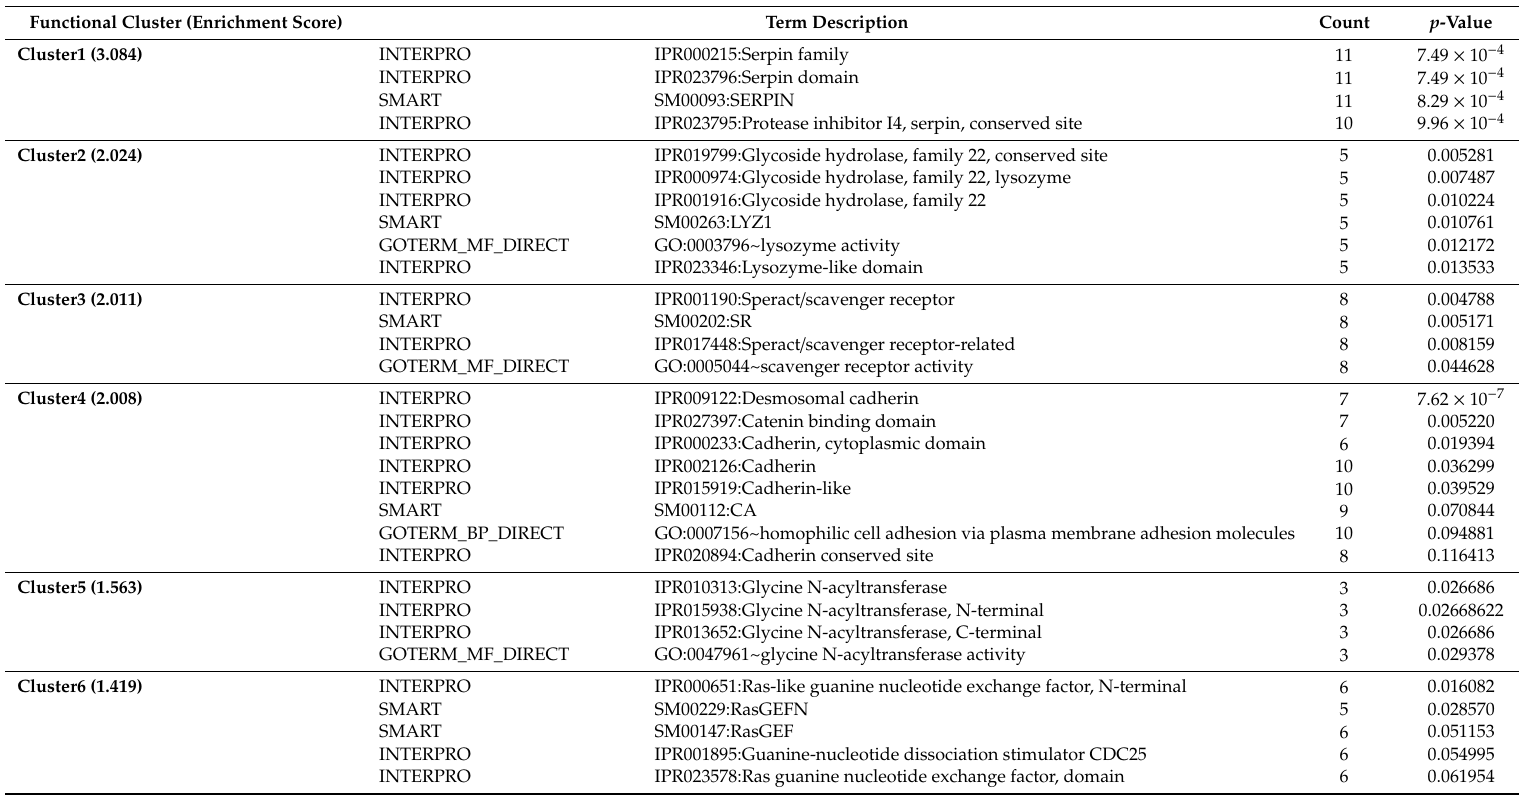
Table 1. Significantly enriched functional term clusters (enrichment score higher than 1.3) for genes identified within candidate genomic regions following DAVID